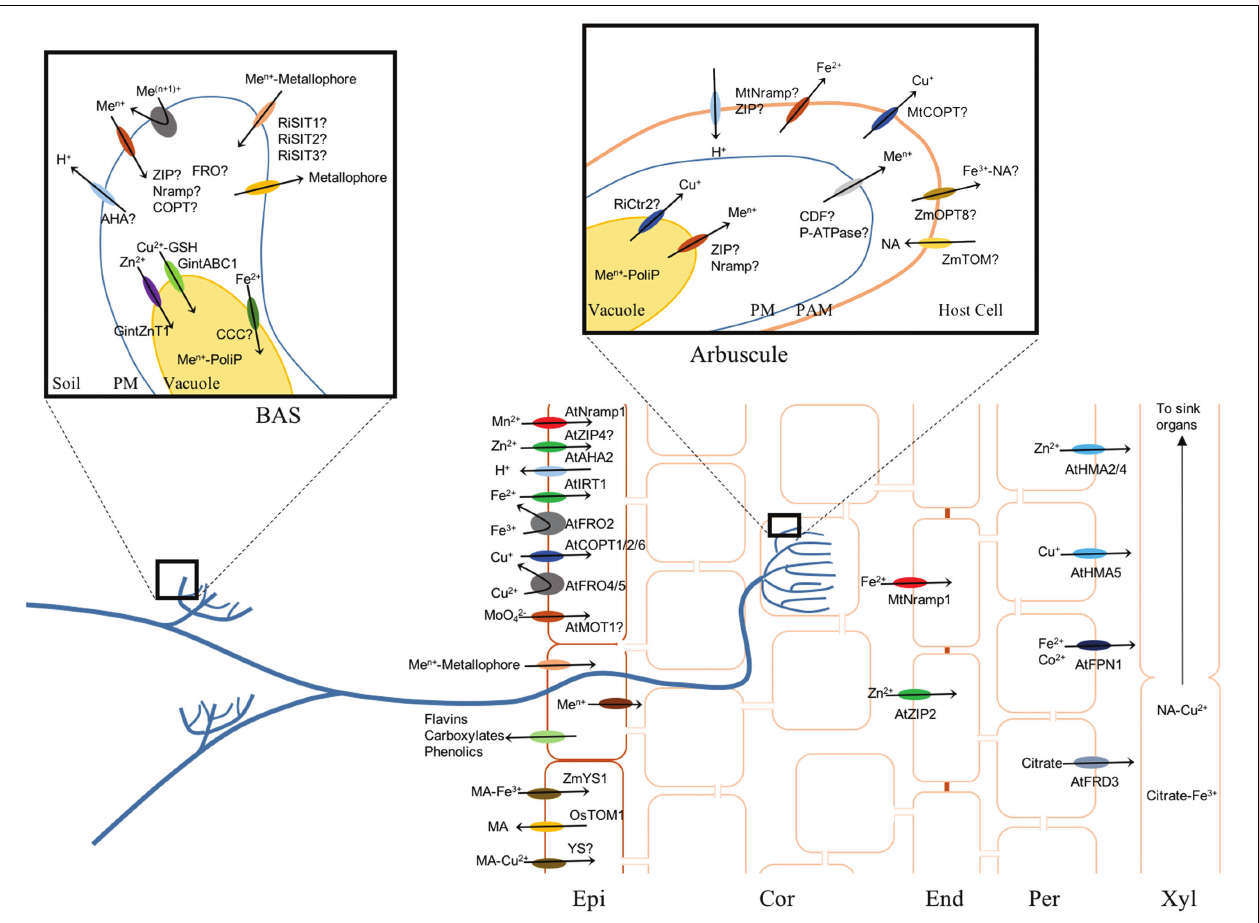
FIGURE 2 | Diagram of the main transport processes in roots, using Strategy I or Strategy II or the mycorrhizal pathway (left inset for uptake by Branched Absorbing Structures, right inset for metal delivery by arbuscules). At is used as a prefix to indicate A. thaliana proteins, Os for Oryza sativa , Zm for Zea mays , Mt for M. truncatula , Gint for Glomus intraradices , Ri for Rhizophagus irregularis , and AMF for arbuscular mycorrhiza. Epi stands for Epidermis, Cor for Cortex, End for Endodermis, Per for Pericycle, Xyl for Xylem, PM for Plasma Membrane, PAM for Periarbuscular Membrane, and Me n + for a general